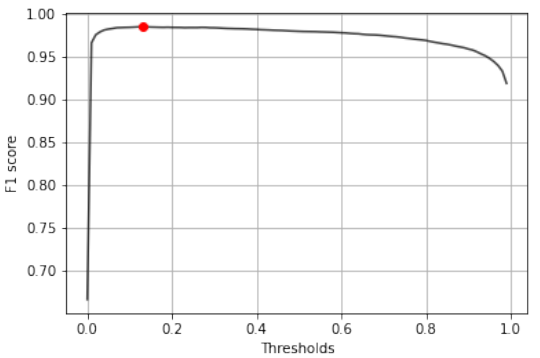
Figure 9. Displaying f1 score changes at different threshold levels between 0 and